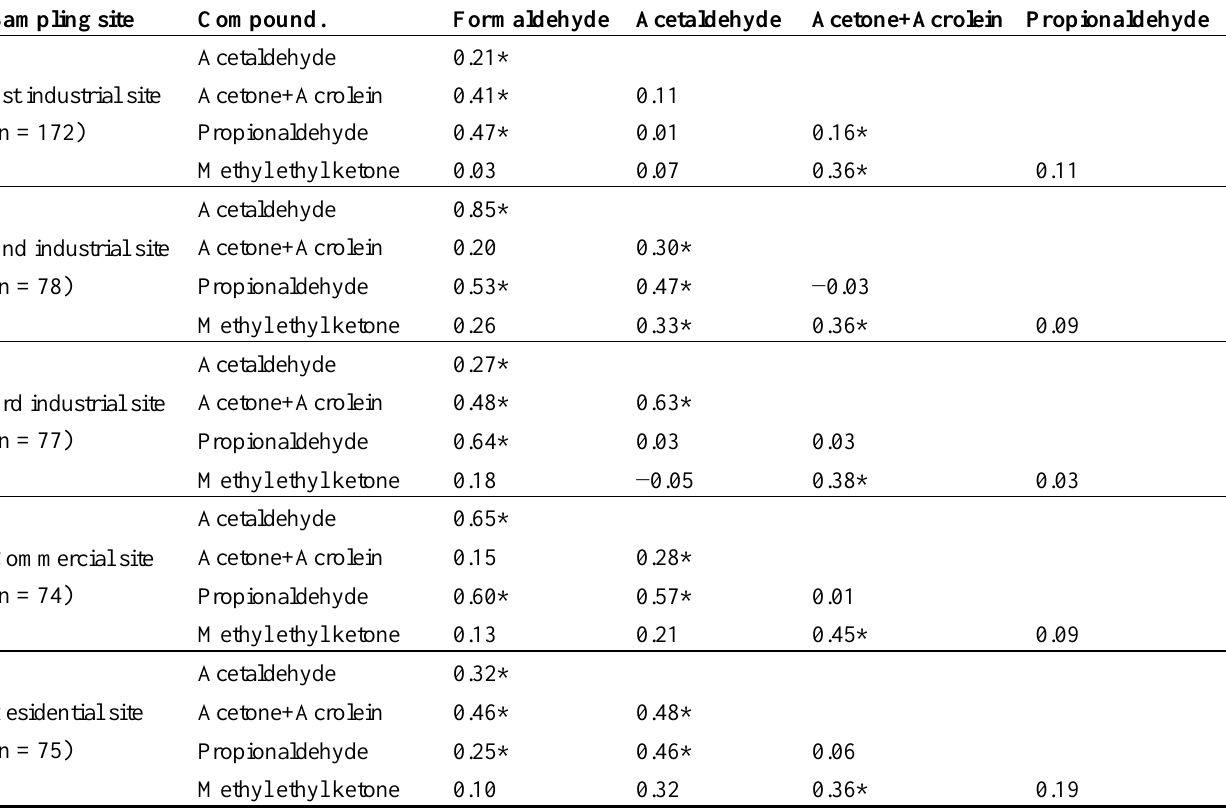
Table 8. Correlation coefficients between different carbonyl compounds. Sampling